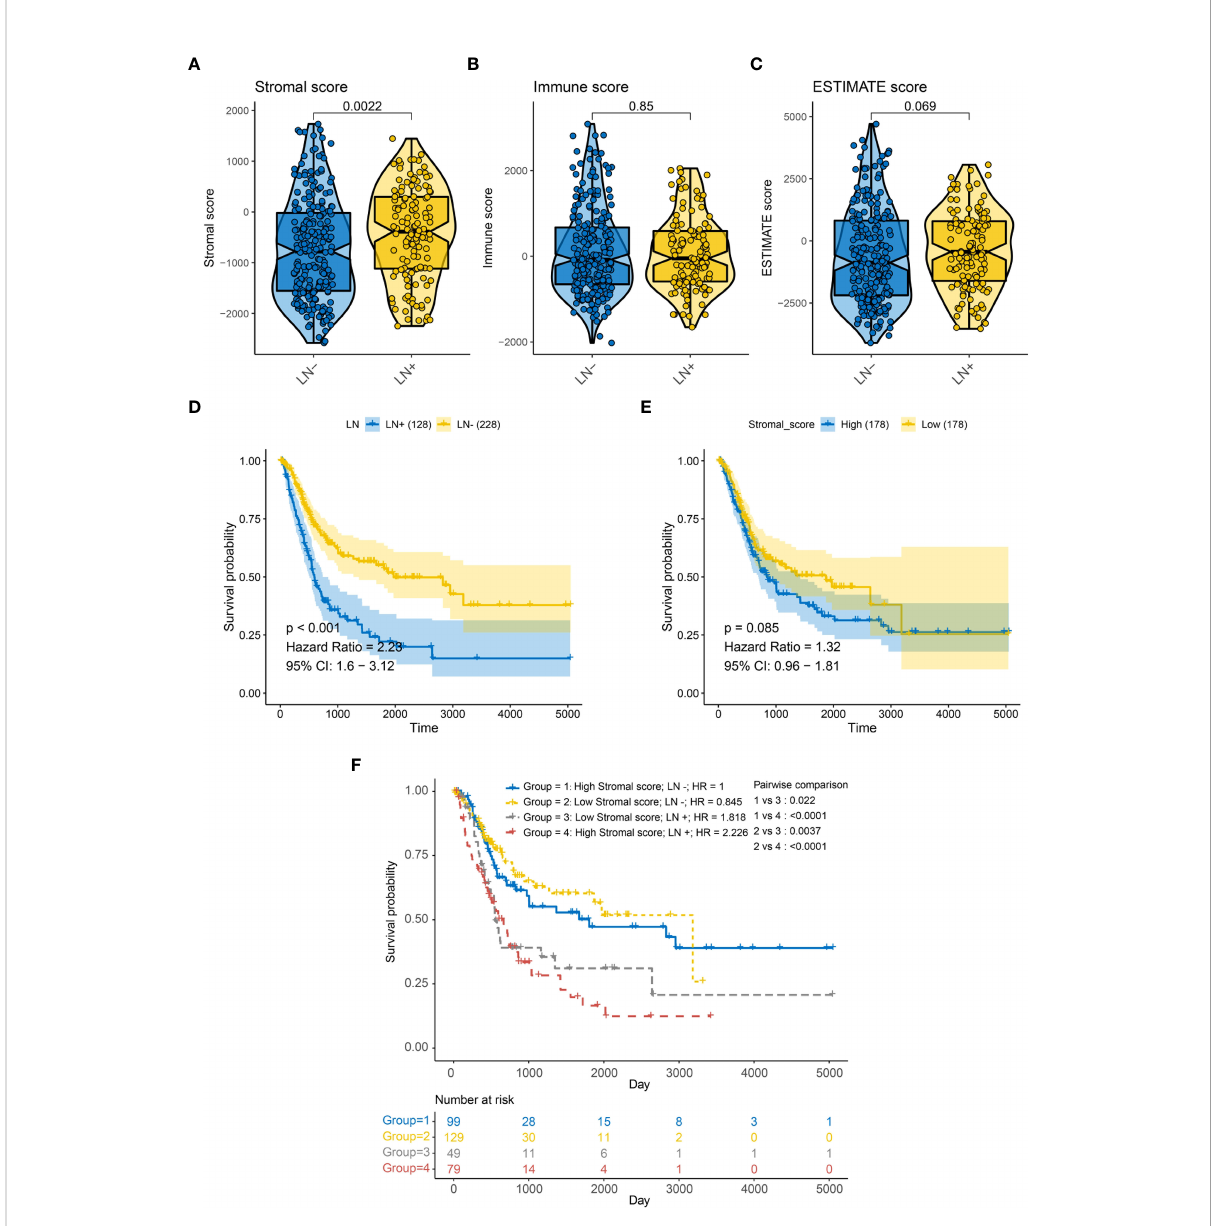
FIGURE 1 Association between LN metastasis status and TME related score of BLCA patients in the TCGA-BLCA cohort for overall survival (OS). (A) Correlation between LN metastasis and Stromal score. (B) Correlation between LN metastasis and immune score. (C) Correlation between LN metastasis and ESTIMATE score. (D) Kaplan-Meier survival curves of LN metastasis (E) Kaplan-Meier survival curves of Stromal score (F) Kaplan- Meier survival curves show the difference in prognosis advantage among four groups strati fi ed by LN metastasis and Stromal